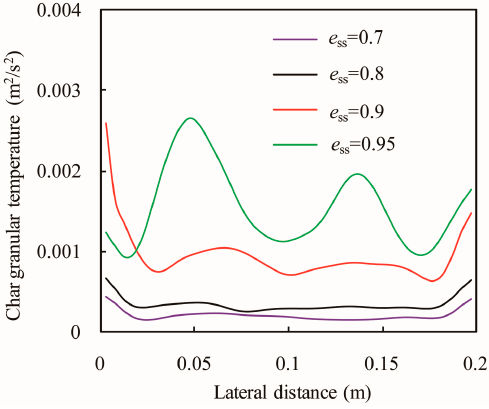
Figure 10. Lateral profiles of the time-averaged granular temperature of the flotsam at Z = 0.153 m.